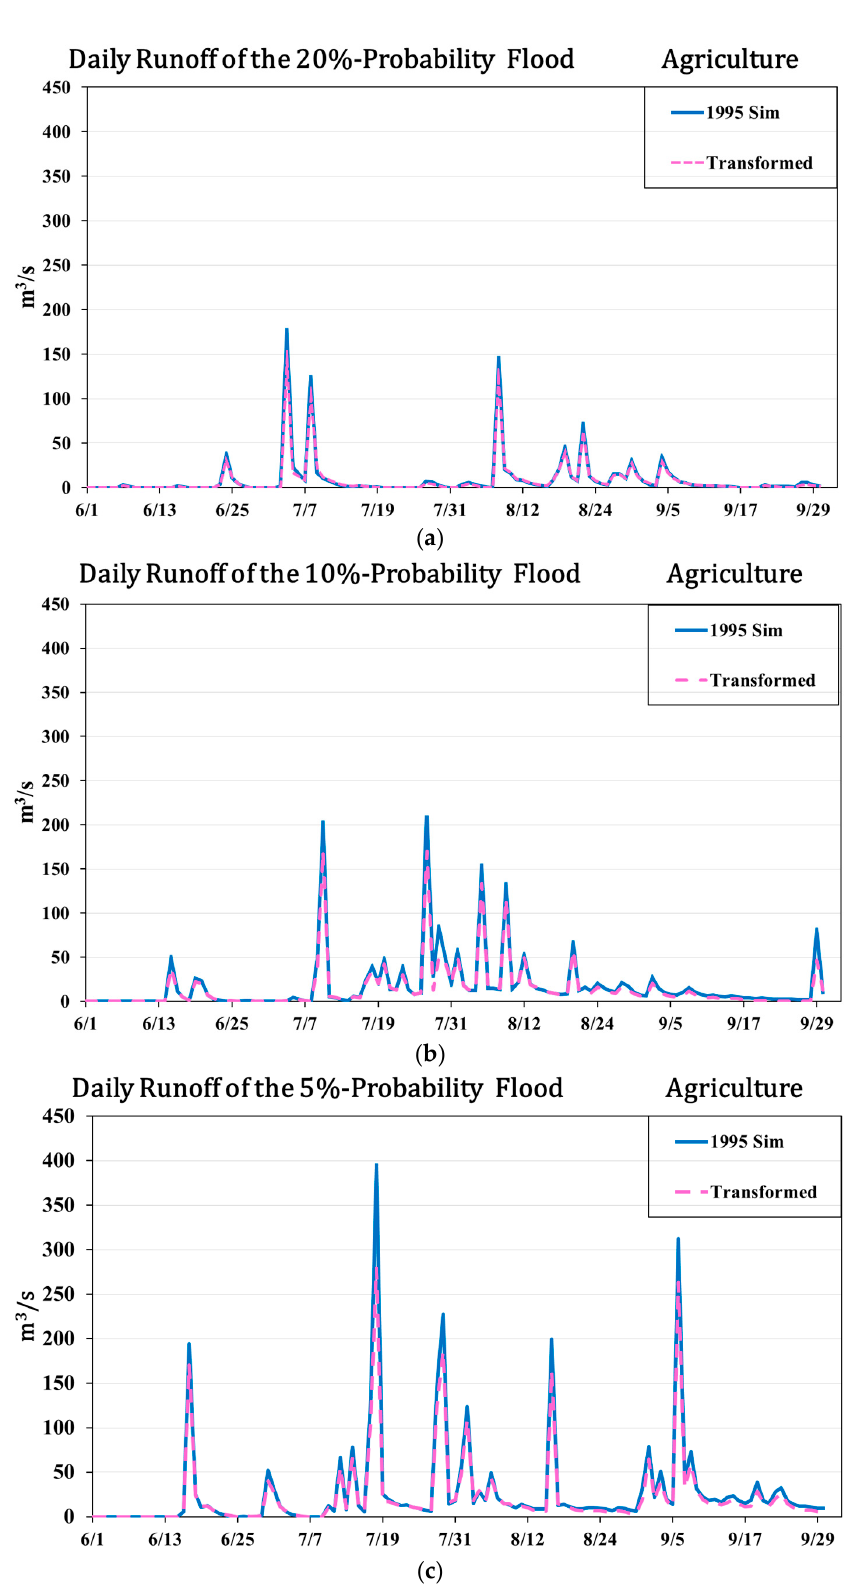
Figure 5. In every panel, the original is the result under the 1995 land use simulated by SWAT model, the transformed is the result under the S1 scenario. ( a ) The comparison of daily runoff processes of the 20% ‐ probability flood; ( b ) The comparison of daily runoff processes of the 10% ‐ probability flood; ( c ) The comparison of daily runoff processes of the 5% ‐ probability flood.